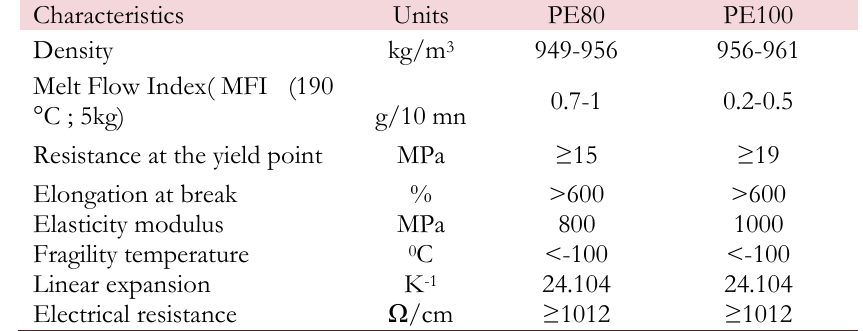
Table 2: Physical characteristics of HDPE [10].